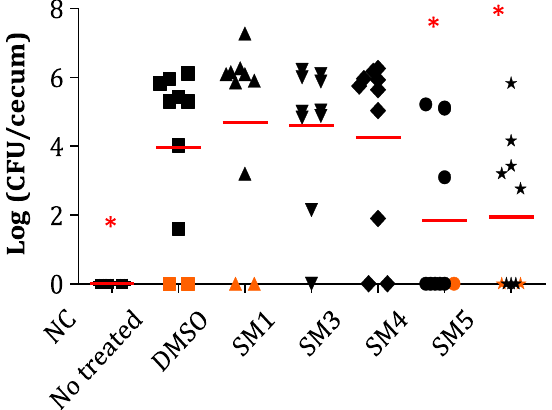
Figure 6. Impact of the small molecule (SM) treatments on Salmonella enterica subsp. enterica serotype Typhimuriumpopulations in chicken ceca. Red line: average; orange dots represent ceca samples that were detected positive for Salmonella after enrichment in tetrathionate broth; n = 10; red line: mean; asterisk: Salmonella populations significantly lower in ceca compared to the 1% dimethyl sulfoxide (DMSO) control (P < 0.01); NC: not treated not infected chickens; Not treated: infected chickens not treated; DMSO: infected chickens treated with DMSO; SM1, SM3-SM5: infected chickens treated with one of the four selected SMs.